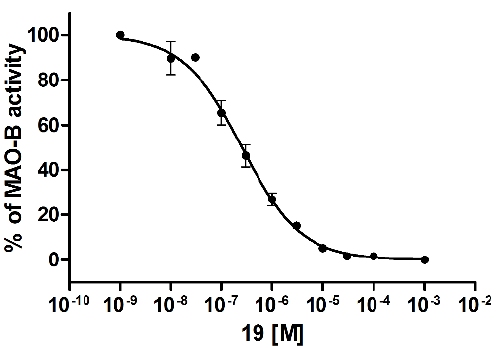
Figure 7. Human monoamine oxidase B IC 50 curve of compound 19 . Data are given as mean ± standard error of the mean of one representative experiment performed in duplicate.